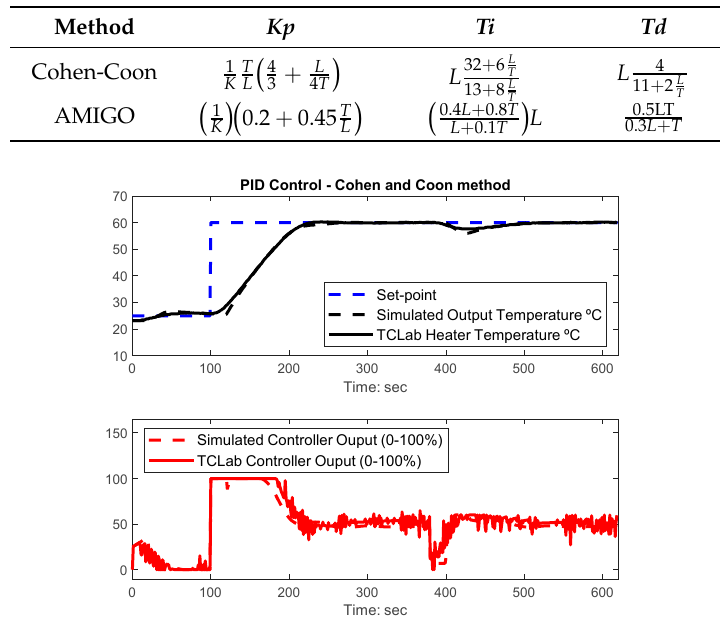
Figure 7. Simulated and TCLab responses using Cohen-Coon